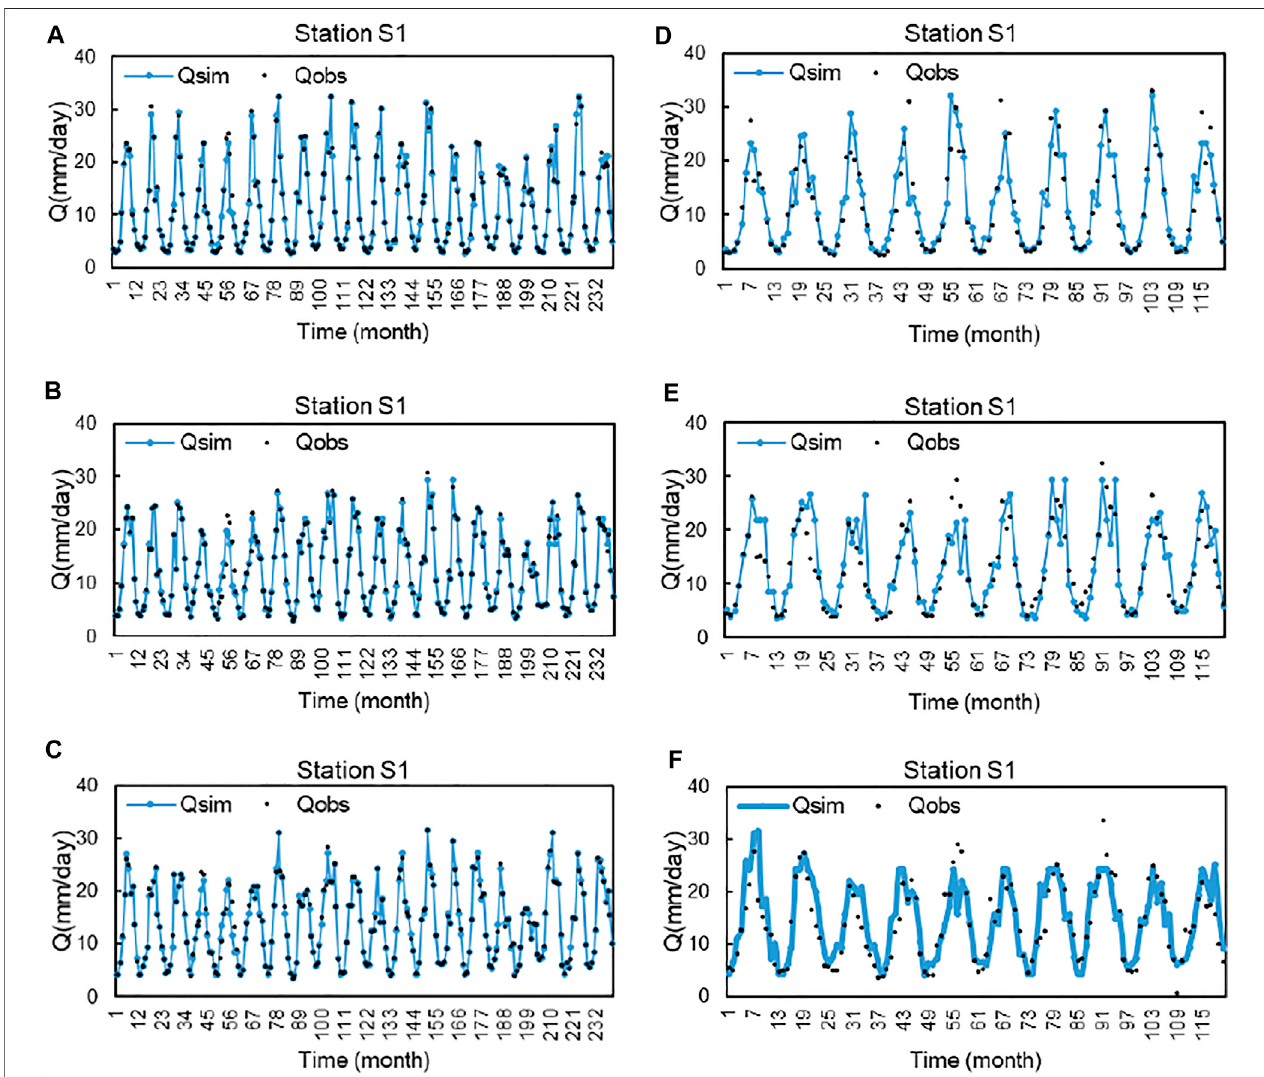
FIGURE5| Comparisonofstream fl owsimulatedbySCAH(thebluelines)withmeasurementvalues(theblackcircle)intheYangtzeRiverwatershed.(Note:the fi rst column presents the calibration period and the second column presents the validation period. Station S1, S2, and S3 represent Yichang station, Hankou station, and Datong station).